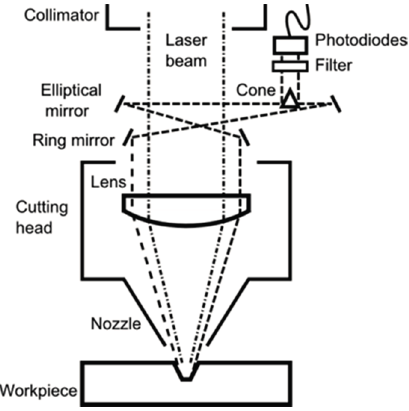
Figure 2. Design of the sensor on top of the cutting head. The dot and dash line show the laser path and the dash line the thermal radiation.